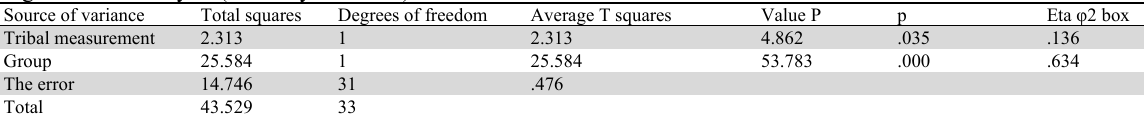
Single contrast analysis (One way ANOVA) Source of variance Total squares Degrees of freedom Average T squares